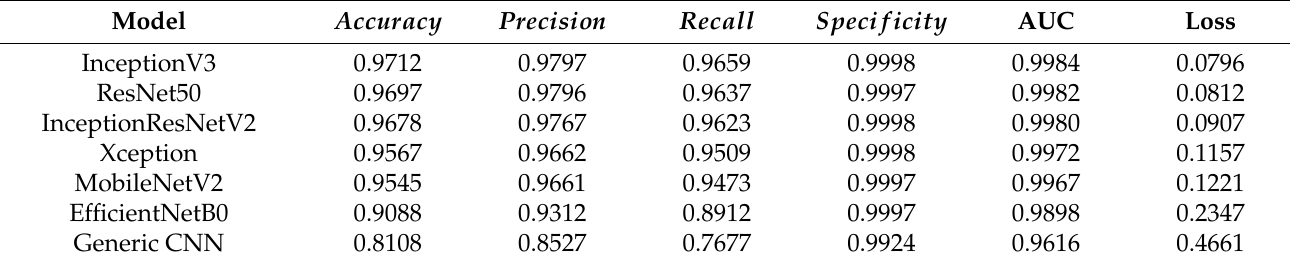
Table 5. Performance Metrics results .